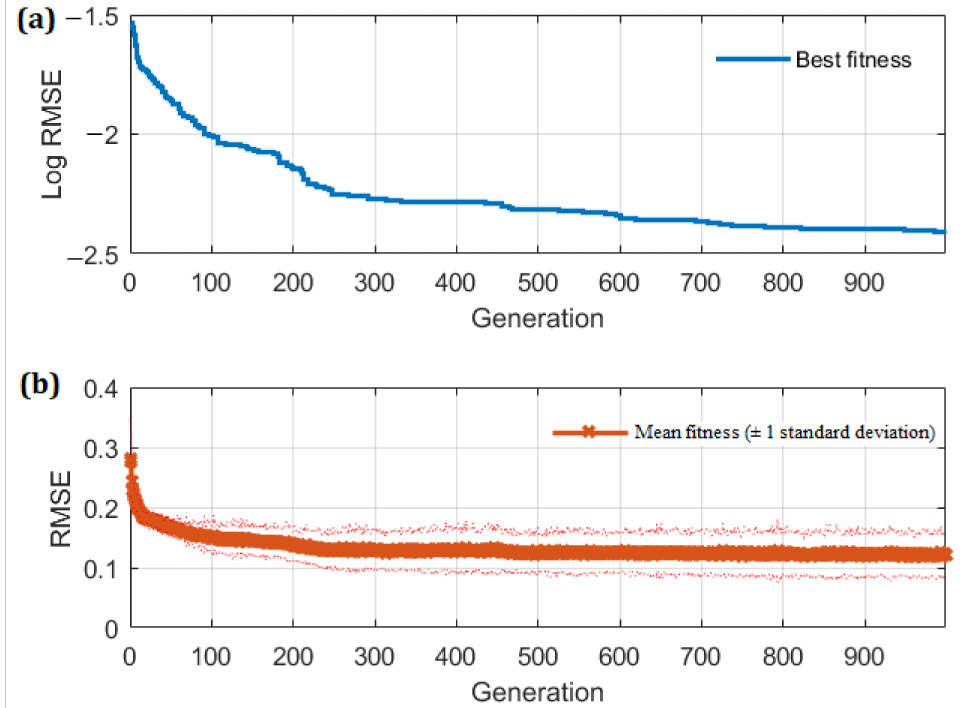
Figure 4. The fitness of the MGGP models in each evolutionary step: ( a ) the best fitness, and ( b ) the mean fitness and standard